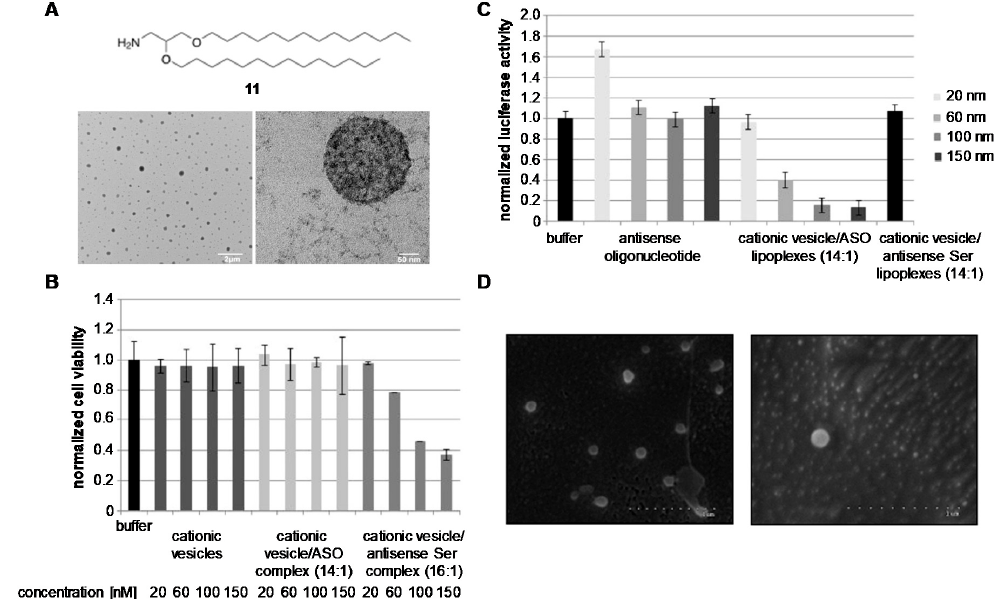
Figure 7. ( A ) Particle size characterization by DLS showing spherical nanosize pattern made up of the cationic lipid 11 ; ( B ) Cellular viabilities of cationic niosomes and nioplexes at different concentrations and N/P ratios; ( C ) Dual-luciferase activity of cationic nioplexes at several concentrations (20,